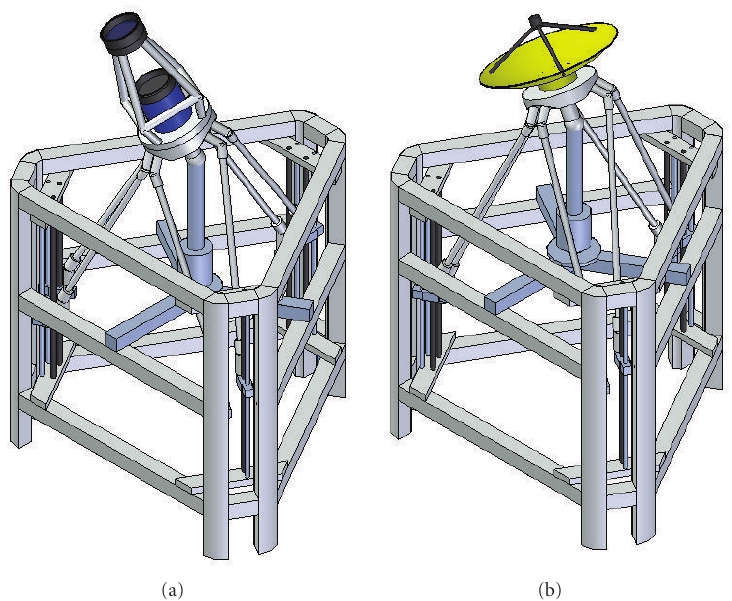
Figure 11: Possible applications of Hexasphere as mounts of